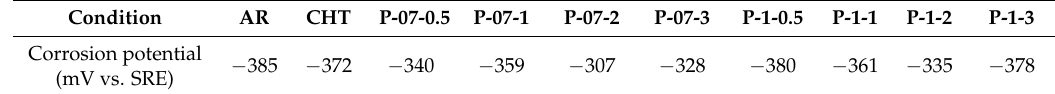
Table 2. Corrosion potentials determined from potentiodynamic polarization